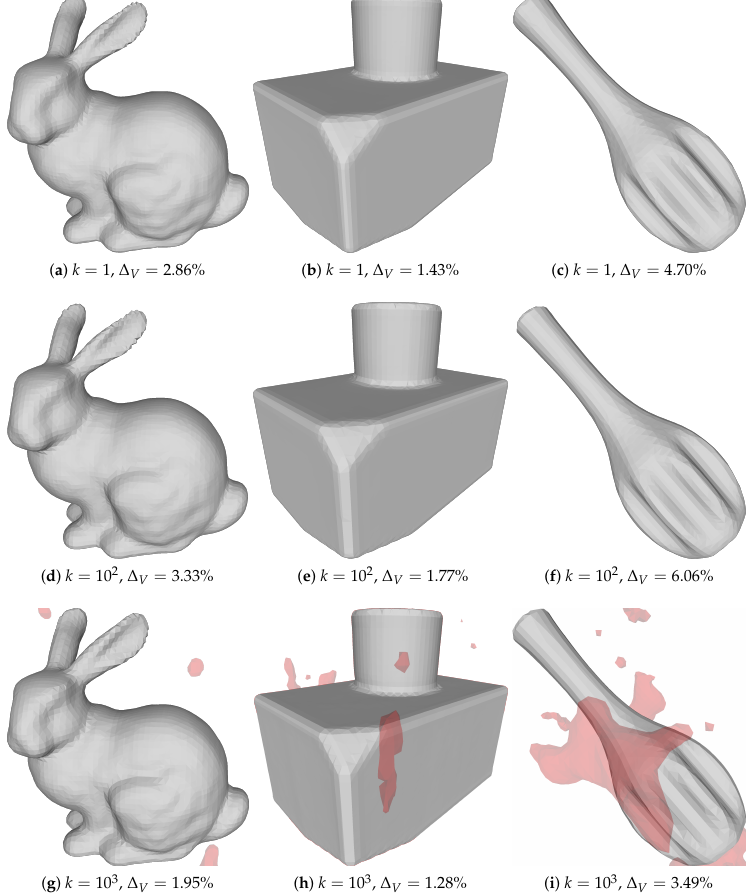
Figure 5. Poisson reconstructions of three different objects, for increasing levels of noise k . The reconstructions for k = 10 3 had a lower ∆ V than the reconstructions at lower noise levels, as these reconstructions were done at an increased octree depth to ensure that the reconstructions had more vertices than the corresponding reconstructions in Figure 3. Red areas do not belong to the largest connected component and have thus not been used in the computation of ∆ V